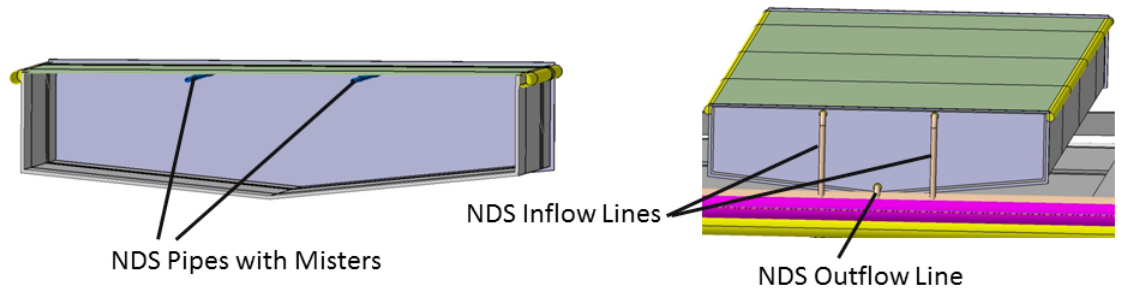
Figure 11: Implementation of the NDS within each growth